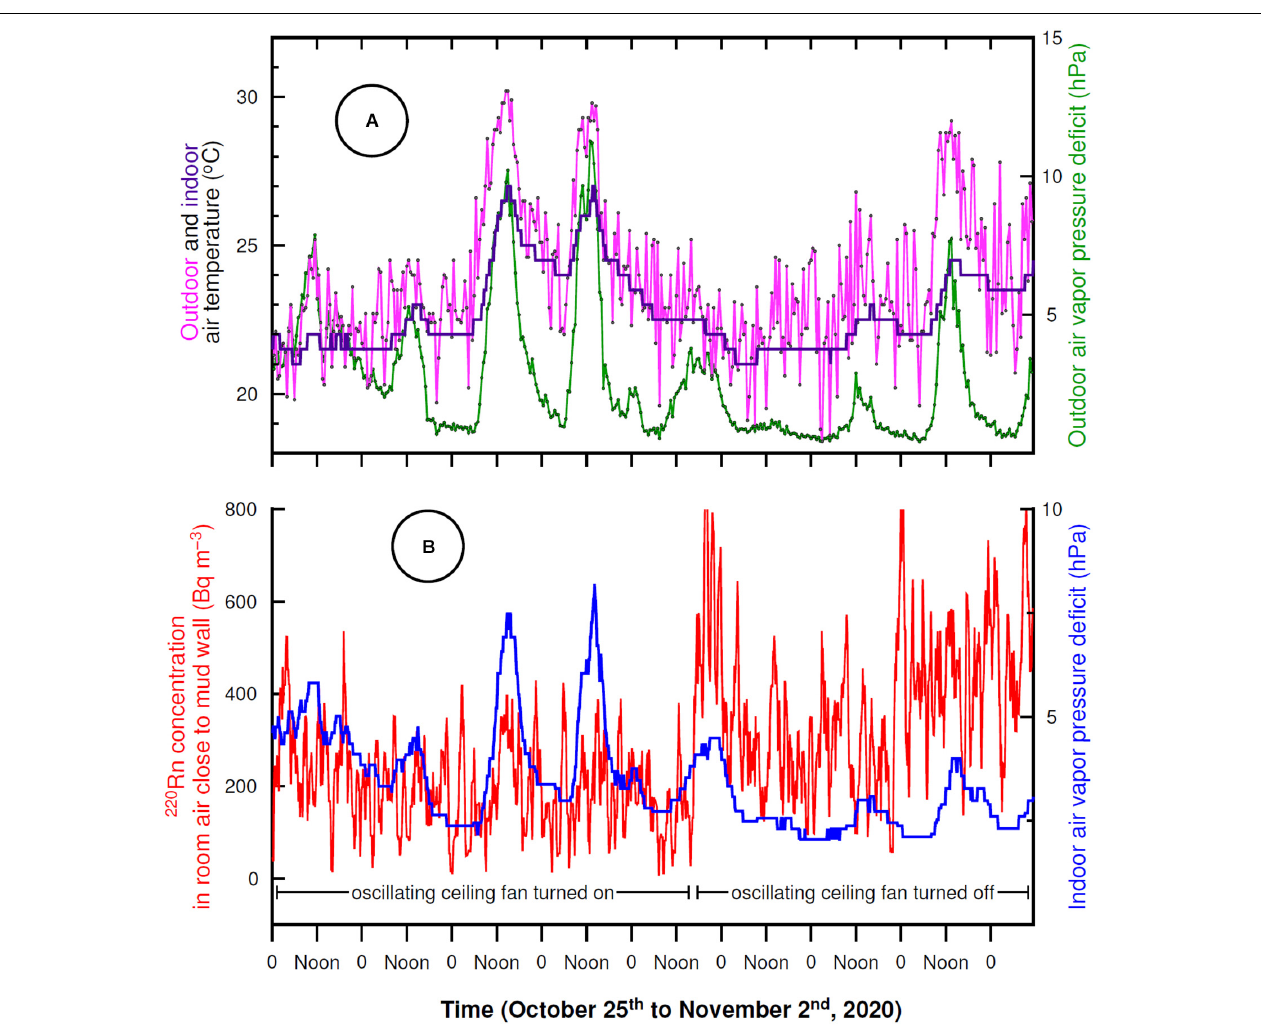
FIGURE 7 | Time-series from a mud house near Hà Nô.i over 9 days documenting hourly moving average values of (A) outdoor and indoor air temperatures, water vapor pressure deficit (VPD) in outdoor air and (B) indoor VPD, and 220 Rn concentrations in room air near the surface of a mud wall ( Figure 3 ) based on data recorded in 10-min intervals by a SARAD R (cid:13) Thoron Scout in October